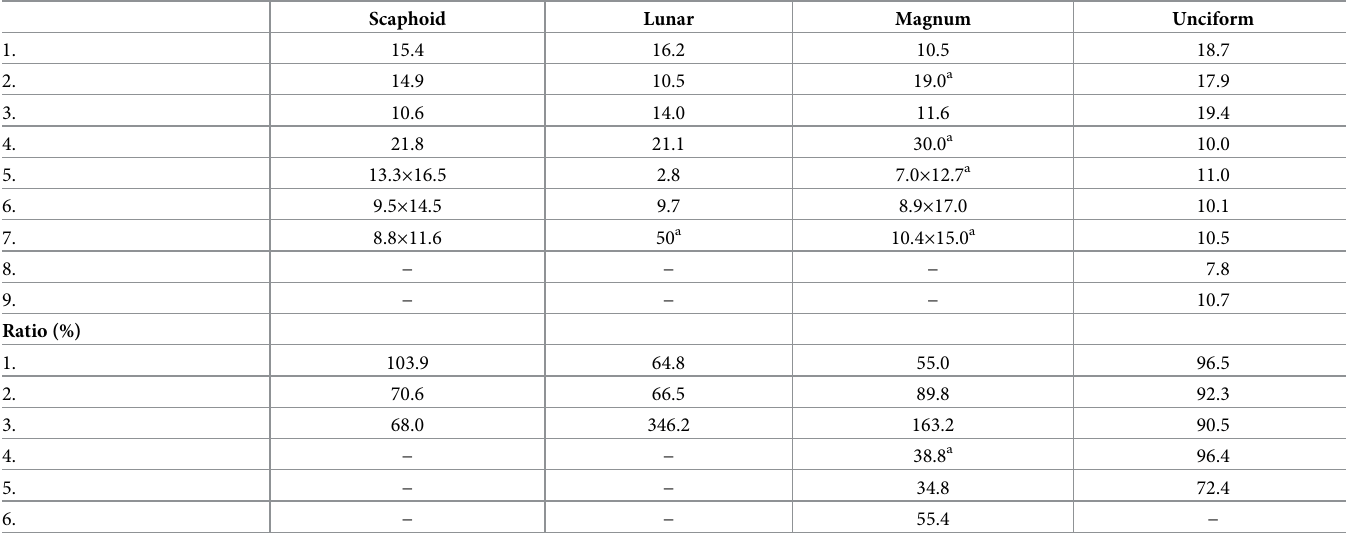
Table 4. Measurements of some carpals of Irenolophus qii (IVPP V 25831) (mm) Measurements correspond to the tables 14, 15, 17, and 42 of Qiu and Wang